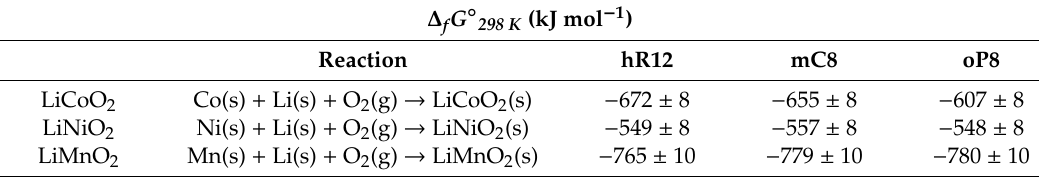
Table 5. Calculated Gibbs Energy of formations at 0 K from elements for all the polymorphs (hR12, mC8 and O) of the LCO, LMO and LNO compounds. Errors have been estimated by propagating the accuracy of the thermochemical supporting data. Energy evaluations involving experimentally reported phases are in